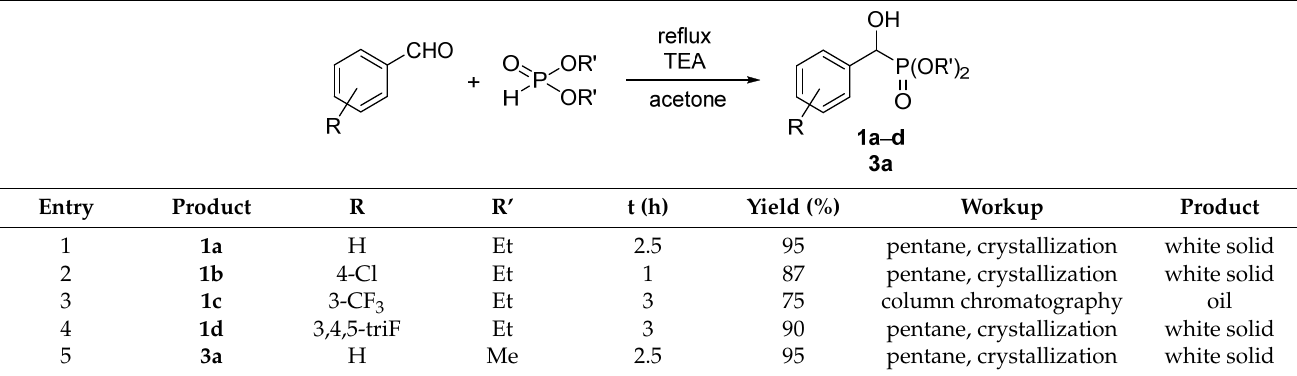
Table 8. Synthesis of α -hydroxyphosphonates [13].